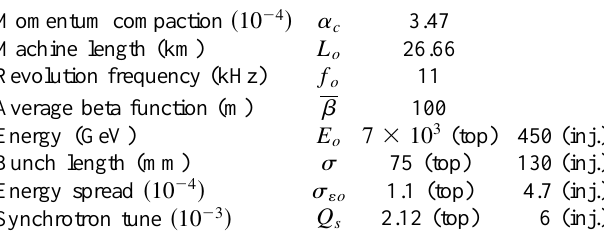
TABLE I. LHC parameter list for two operating conditions, namely, at top energy (top) and at injection energy